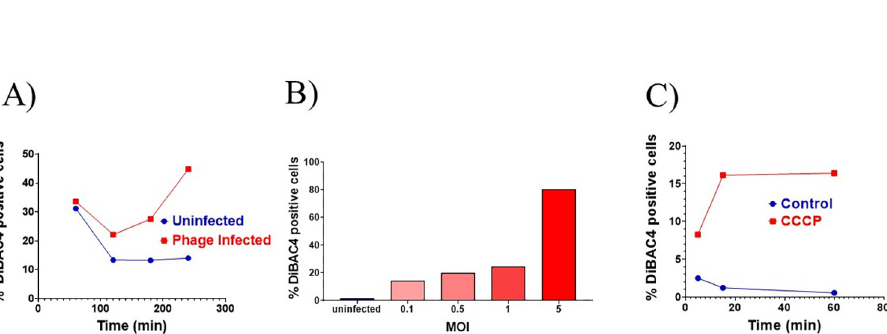
Fig 4. SEM micrographs depicting (A) Msm (B) Phage adsorption (C) Membrane blebbing (D) Pore formation in the membrane and (E) cell lysis.